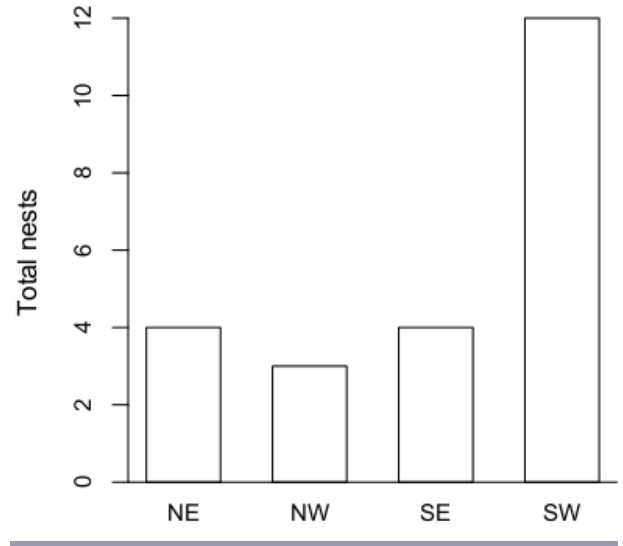
Fig. 1 . Total number of Worm-eating Warbler ( Helmitheros vermivorum ) nests located on NE [0-90], SE [90-180], SW [180-270], and NW [270-360] facing slopes during the 2016 and 2017 breeding seasons in southern